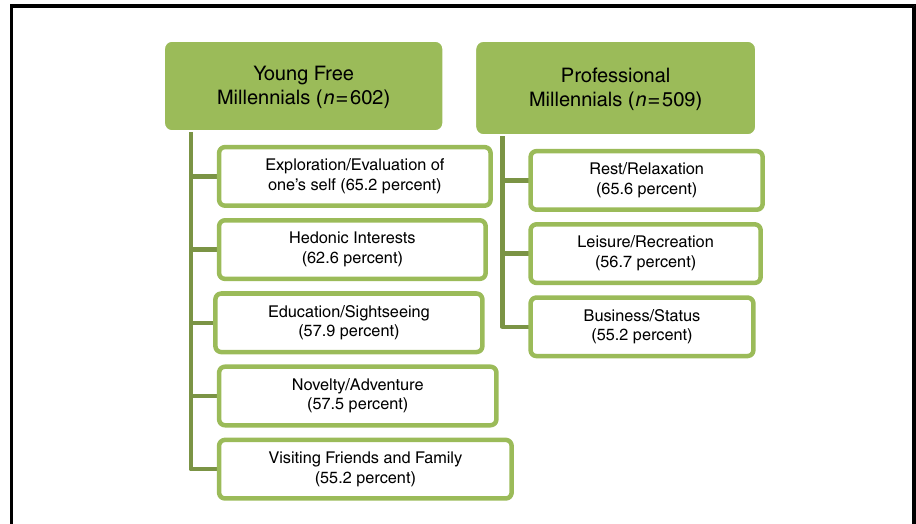
Figure 1 Travel motivation differences among millennial groups